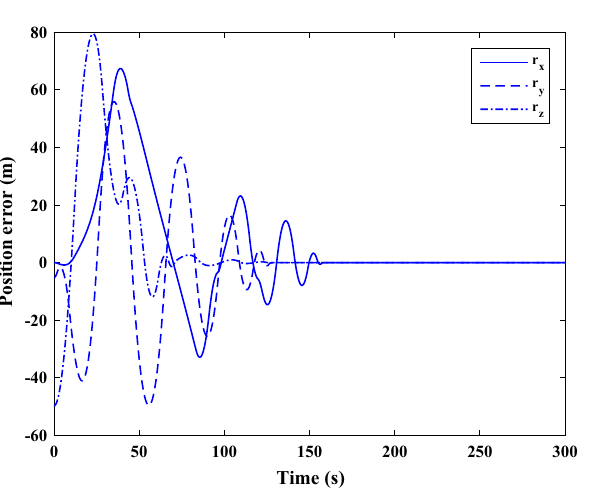
Figure 26. Scenario I: position tracking (in chaser body frame).